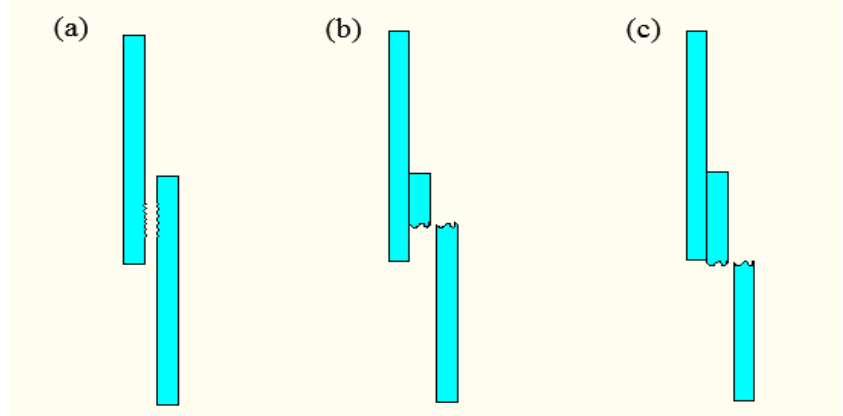
Figure 3. Failure modes of plastic welding parts. ( a ) Interface failure; ( b ) the base sheet fracture along the welding joint; ( c ) bulk base sheet fracture